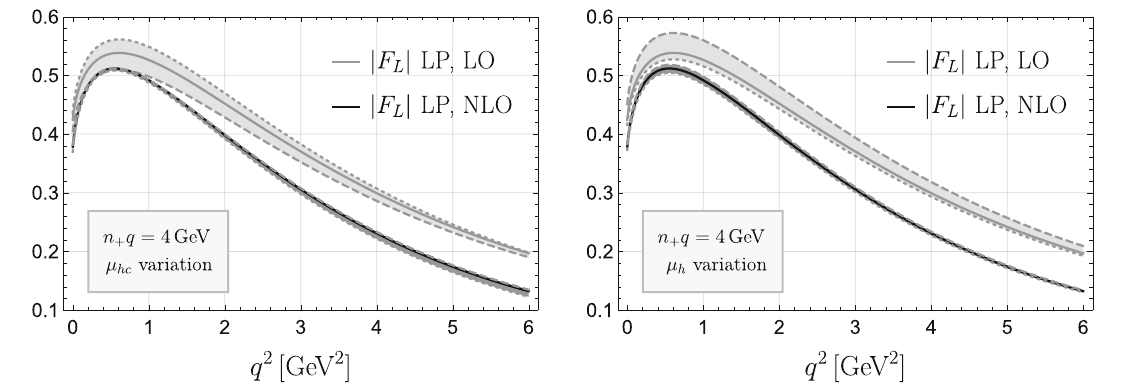
| at leading order (LP, LO) and next-to-leading order (LP, Fig. 3 | F LP L NLO) as a function of q 2 . The bands represent the scale uncertainty from μ hc = 1 . 5 ± 0 . 5 GeV (left) and μ h = 5 + 5 −